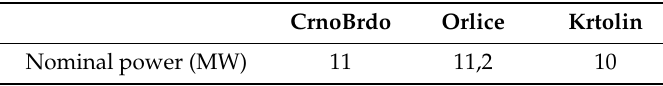
Table 2. Wind farms–nominal power